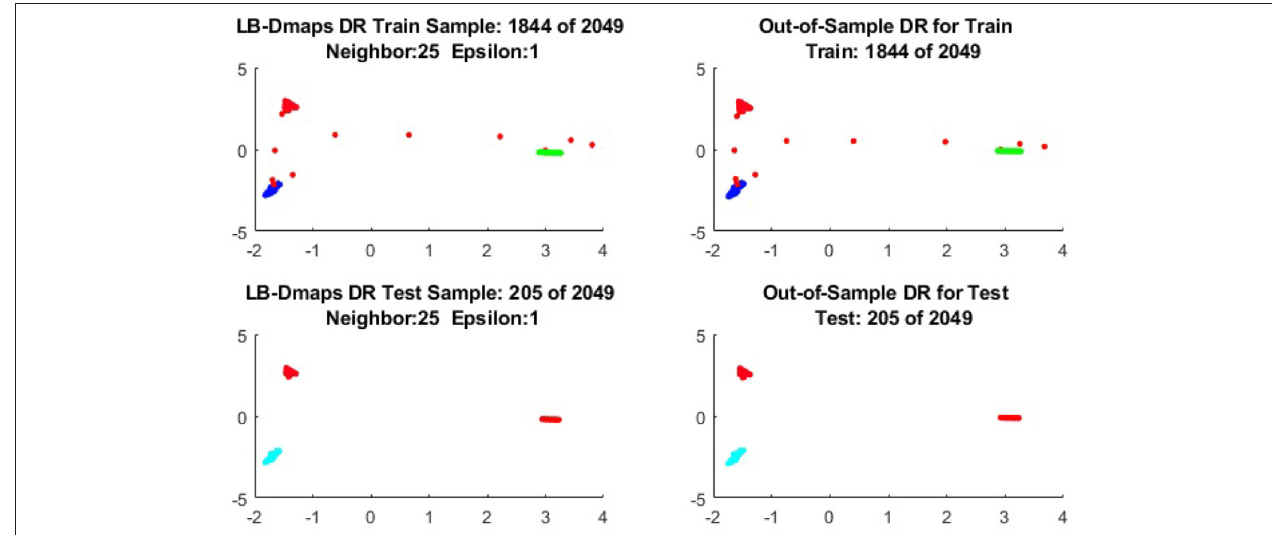
FIGURE 12 | Comparisons of DRs of training data and the testing data, respectively, for 3D Cluster.